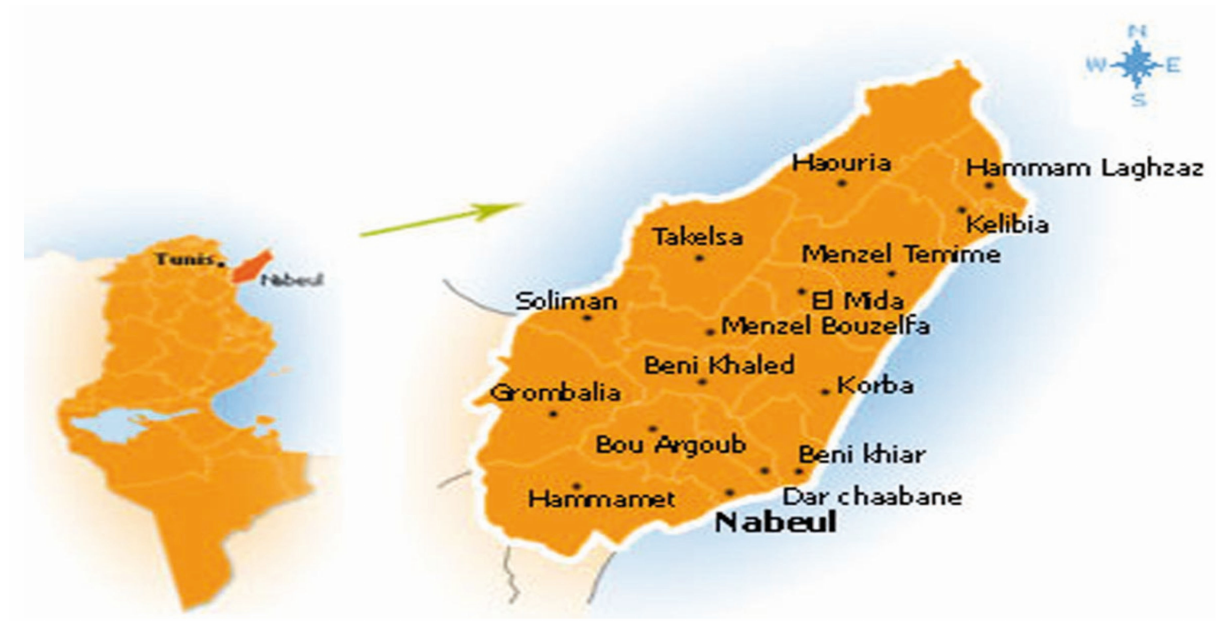
Figure 1. Study area. Source: Institut de Recherche sur le Maghreb Contemporain